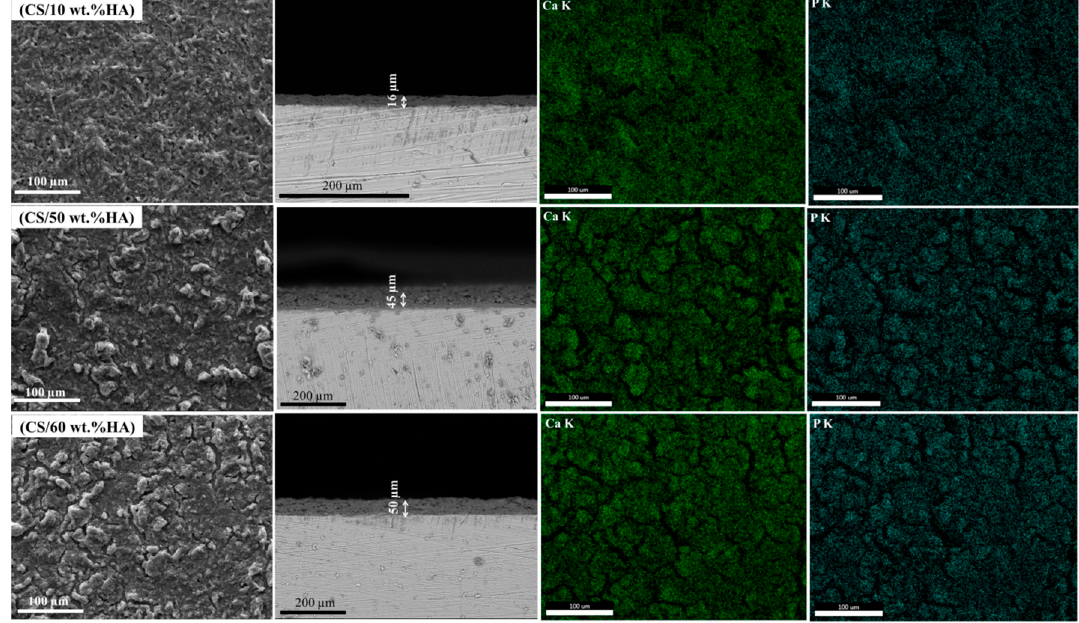
Figure 2. Surface morphology in cross section and EDS mapping of CS-HA coatings with 10, 50 and 60 wt.% of HA.